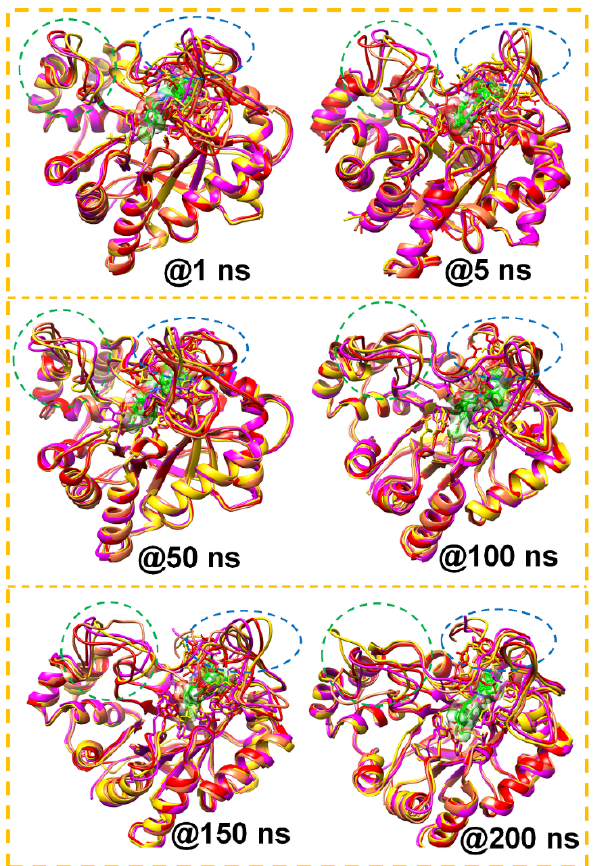
Figure 9. The MD simulation snapshots showed the loop structures at the time interval (ns) 1, 5, 50, 100, 150, and 200. Residues in the 218–228 region are enclosed in green and those in the 300–318 region are enclosed in blue circles.